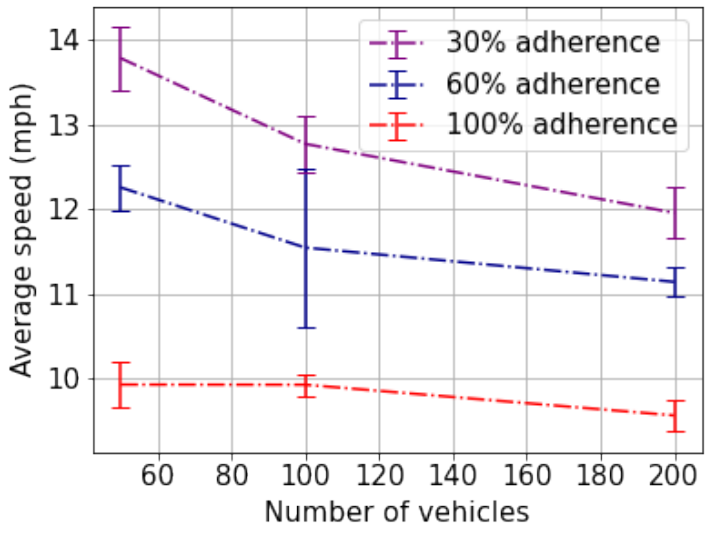
Figure 5. Average speed of vehicles against number of vehicles for each adherence scenario, refer to Supplementary Materials for data